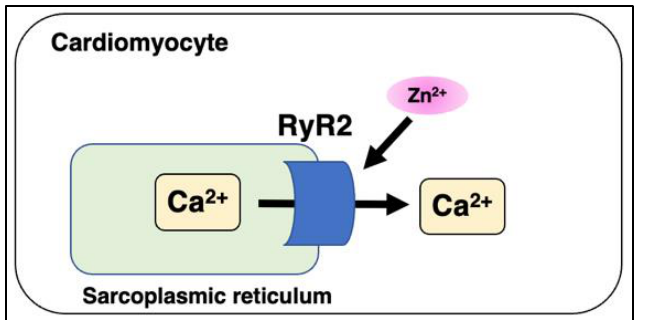
Figure 8. Zinc is involved in ryanodine receptor functions . Schematic of the zinc-mediated function of RyR2 in the SR. Aberrant intracellular zinc levels regulate calcium release via RyR2 and mitsugumin 23 from the